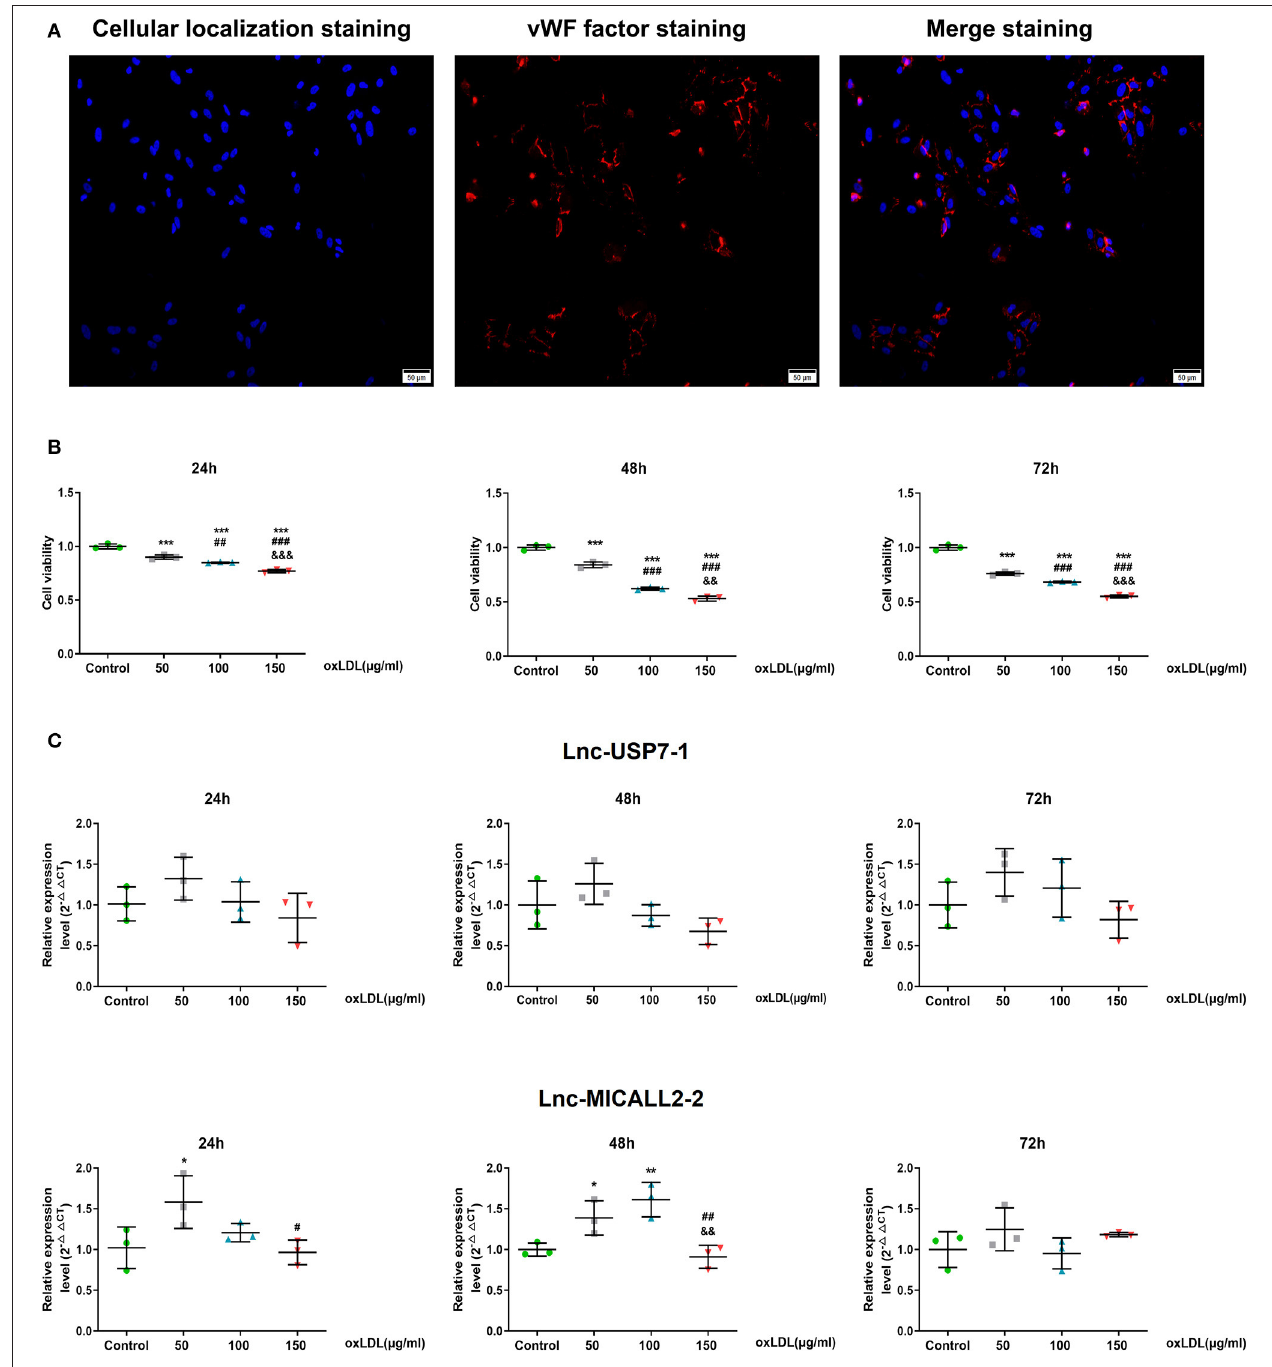
FIGURE 3 | The expression levels of differentially expressed lncRNAs in HCAECs. (A) Purification identification of HCAECs by vWF. vWF factor (red) and cellular localization (blue) double staining ( × 200 times) of HCAECs. (B) Cell viabilities were compared after culturing at different concentrations of oxLDL for 24, 48, and 72h ( n = 3/group). (C) Comparison of the expression levels of differentially expressed lncRNAs after cell culture at different concentrations of oxLDL for 24, 48, and 72h ( n = 3/group). Values are expressed as the mean ± SD. * p < 0.05, ** p < 0.01, *** p < 0.001 vs. normal HCAECs; # p < 0.05, ## p < 0.01, ### p < 0.001 vs. 50 µ g/ml oxLDL; && p < 0.01, &&& p < 0.001 vs. 100 µ g/ml oxLDL in panels b and c. Data are expressed as means ± SD. one-way ANOVA was used for all comparisons.